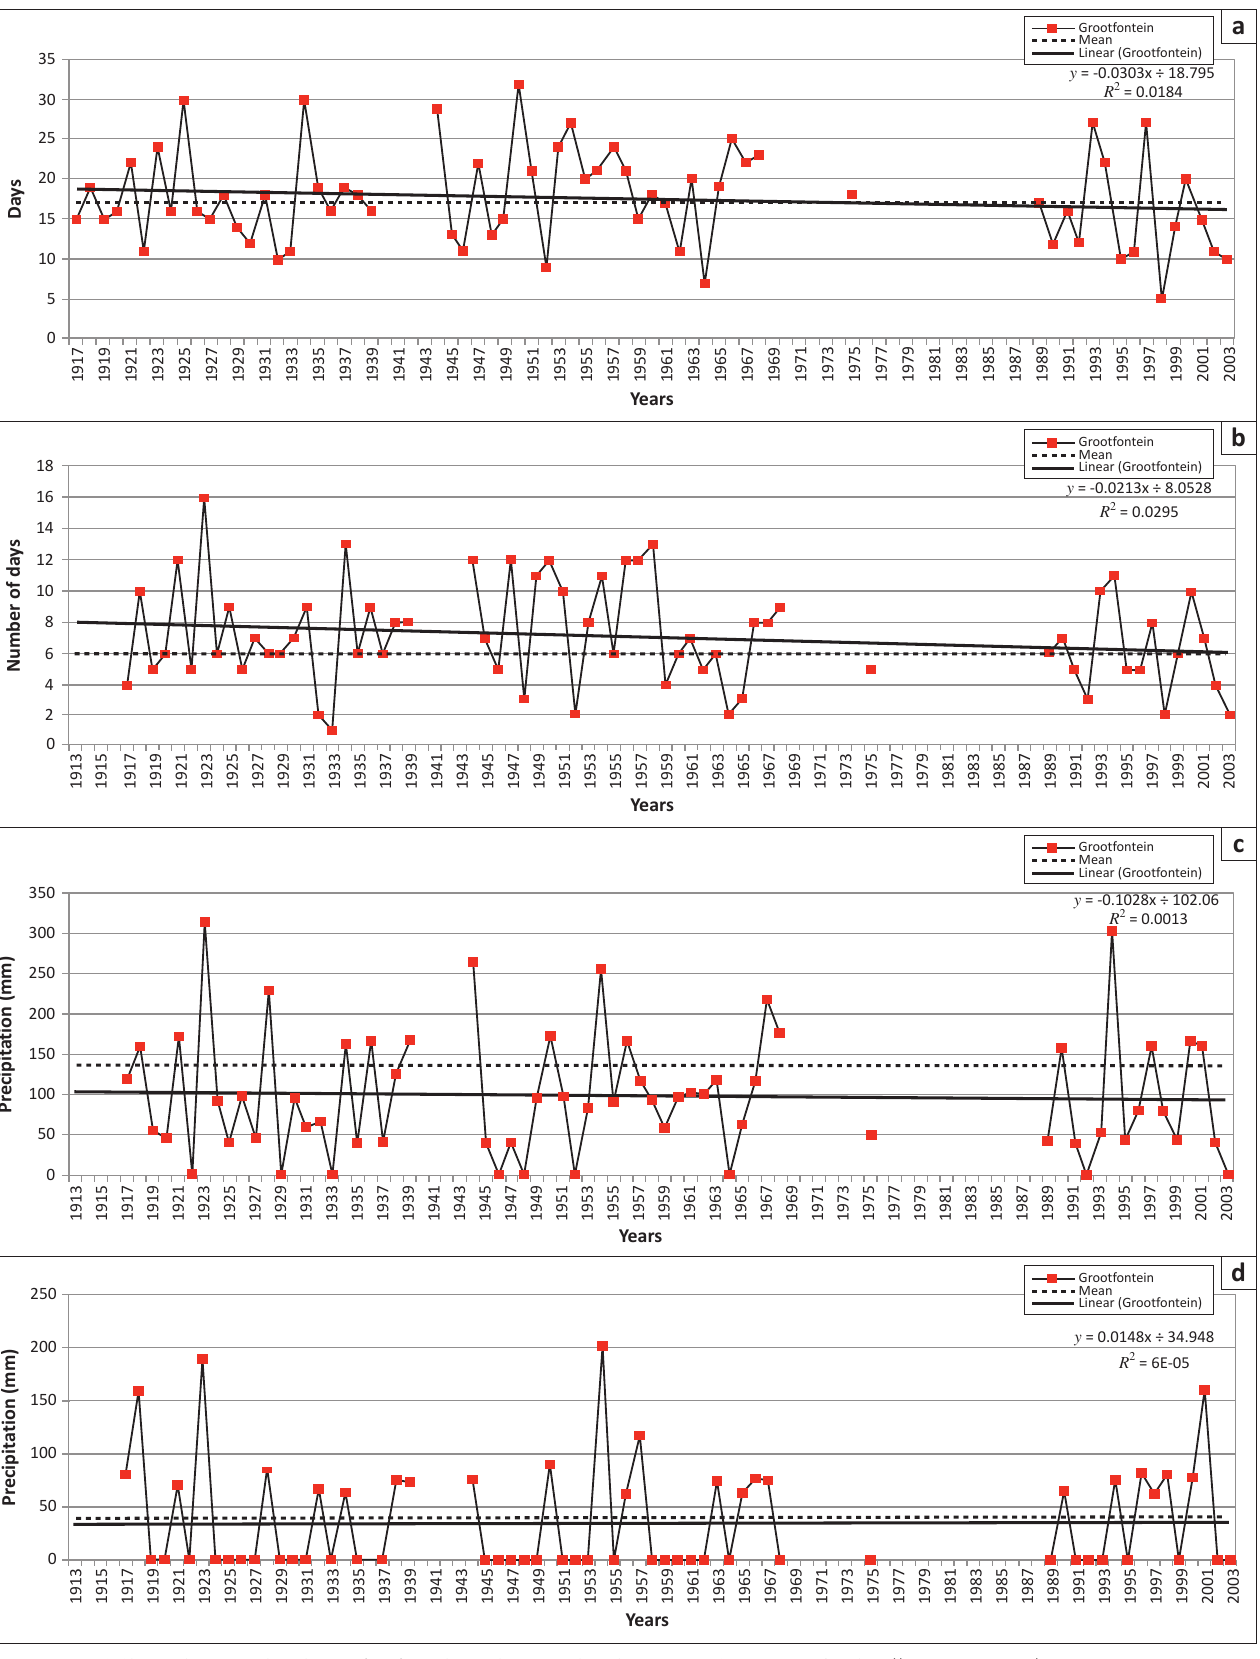
FIGURE 7: Ten climate change extreme precipitation indices for the Grootfontein rainfall station: (a) annual count of days when RR > 10 mm; (b) annual count of days when RR >= 20 mm; (c) annual total precipitation when RR > 95 th percentile of 1961–1990 daily rainfall; (d) annual total precipitation when RR > 99th percentile of